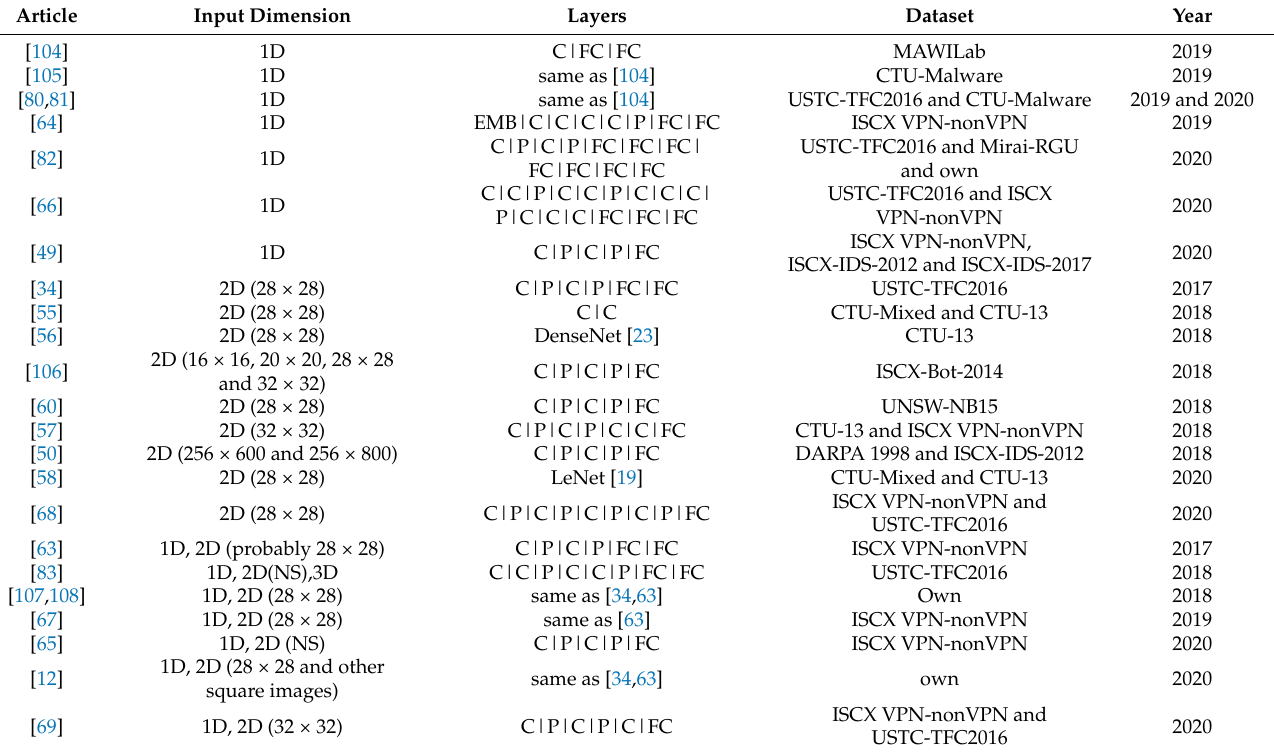
Table 4. All research works of the flow transformation